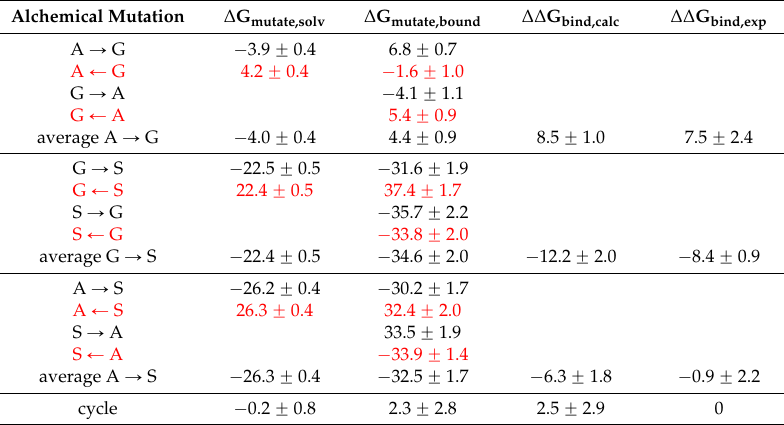
Table 1. Comparison of values for ∆ G mutate and ∆∆ G bind , in kJ ¨ mol ´ 1 .